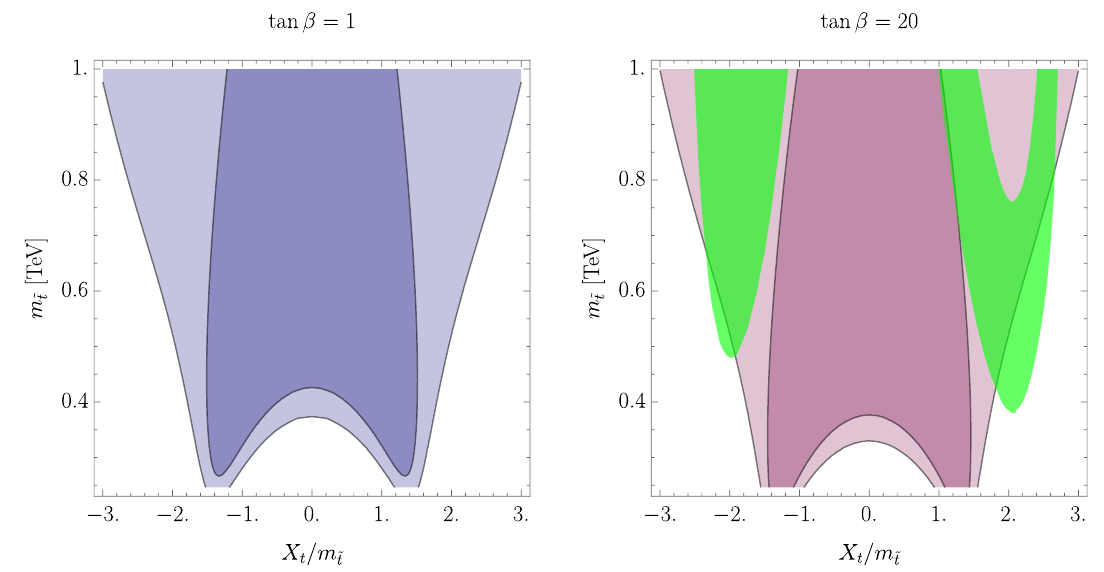
Figure 7. The allowed degenerate stop parameter space with tan (cid:12) = 1 (left) and tan (cid:12) = 20 (right), where the darker and lighter blue regions are within 1- and 2- (cid:27) of the minimum of the (cid:31) 2 function, respectively. In addition, the green shading indicates the region where M h 2 (122 ; 128) GeV